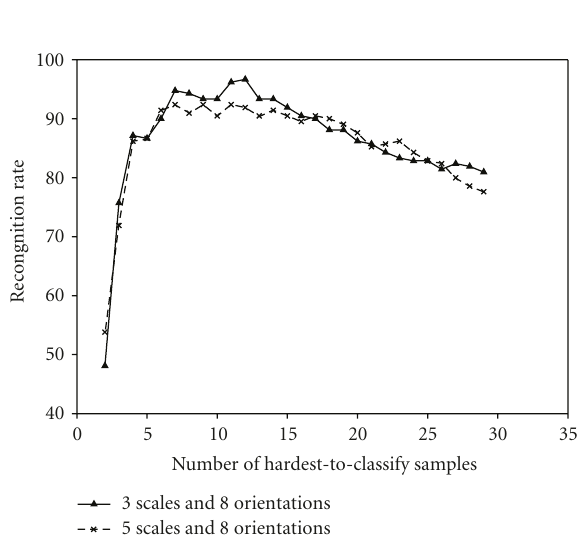
Figure 6: A comparison of di ff erent numbers of hardest-to-classify